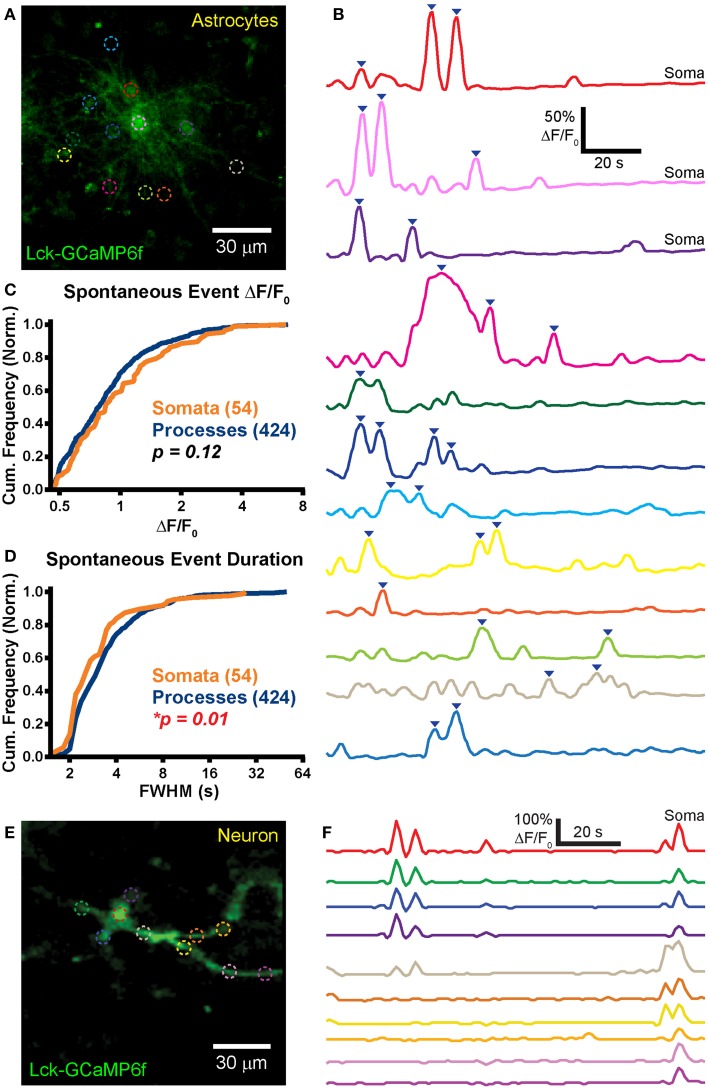
Robust spontaneous transients are observed in astrocytic somas and processes in hippocampal organotypic slice cultures. (A) Example mean calcium activity projection image of astrocytes expressing Lck-GCaMP6f in a hippocampal organotypic slice culture. ROIs are denoted by dashed circles including three adjacent somas. (B) ΔF/F0 traces of ROIs shown in (A). Line colors in (B) correspond to ROI colors in (A). Inverted blue arrows mark peaks that reached threshold and were included as events for analysis. “Merged” events, which encompass two proximate peaks, were counted as a single long event (see dark pink and dark green ROIs). (C) A cumulative histogram displaying the relative frequency (event counts normalized by total events in each structure) of spontaneous event peak ΔF/F0 values. The number of total events in each structure is shown in parentheses next to the structure name. (D) A cumulative histogram displaying spontaneous event duration. Soma data is shown in orange and process data in blue. The distribution of each measurement was compared between somas and processes. The calculated p-value from a Kolmogorov–Smirnov test is shown in the plot. Red text denotes significance and black text denotes no significance detected at a level of p < 0.05. (E) Example mean calcium activity projection of a neuron expressing Lck-GCaMP6f. (F) ΔF/F0 traces corresponding to ROIs shown in (E).